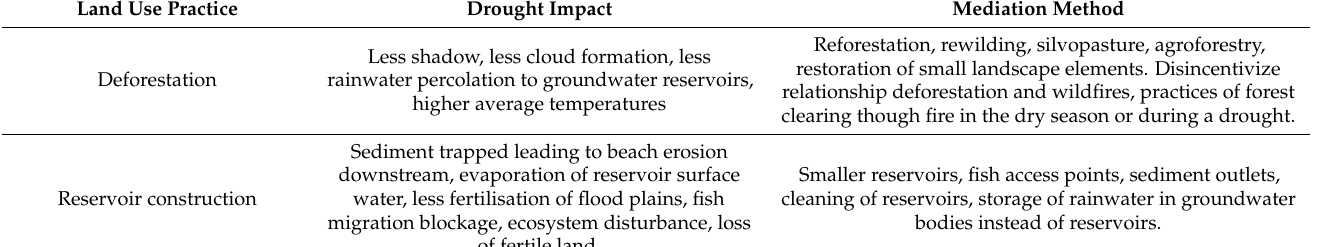
Table 2. Land use practices, possible drought impacts, and mediation